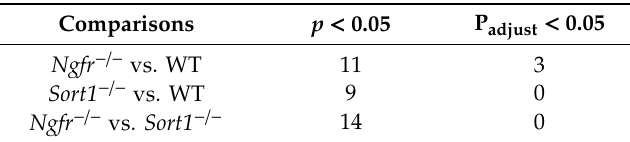
Figure 8. Differentially expressed tRNAs in EVs derived from Ngfr − / − and Sort1 − / − compared with EVs from WT Schwann cells. ( a ) Heatmap covering the most significantly changing tRNAs, with p -values (not multiple-testing corrected) below 0.05 in one or more of the pairwise comparisons. Top annotation shows Sort1 − / − in orange, Ngfr − / − in yellow and control WT as blue. Shown are z scores of log2-transformed RPM values. ( b ) Volcano plot for EV tRNAs from Ngfr − / − versus WT comparison and ( c ) Volcano plot for EV tRNAs from Sort1 − / − versus WT. Plotted are – log10( p -values) vs. − log2(fold change). Red means < 0.05 adjusted p -value. Vertical lines indicate +/ − 1 log2(fold change). The names for the 10 most significant tRNA are indicated. Table 5. Numbers of di ff erentially expressed tRNAs with p adjust values below 0.05 or p values (without adjusting for multiple testing) below